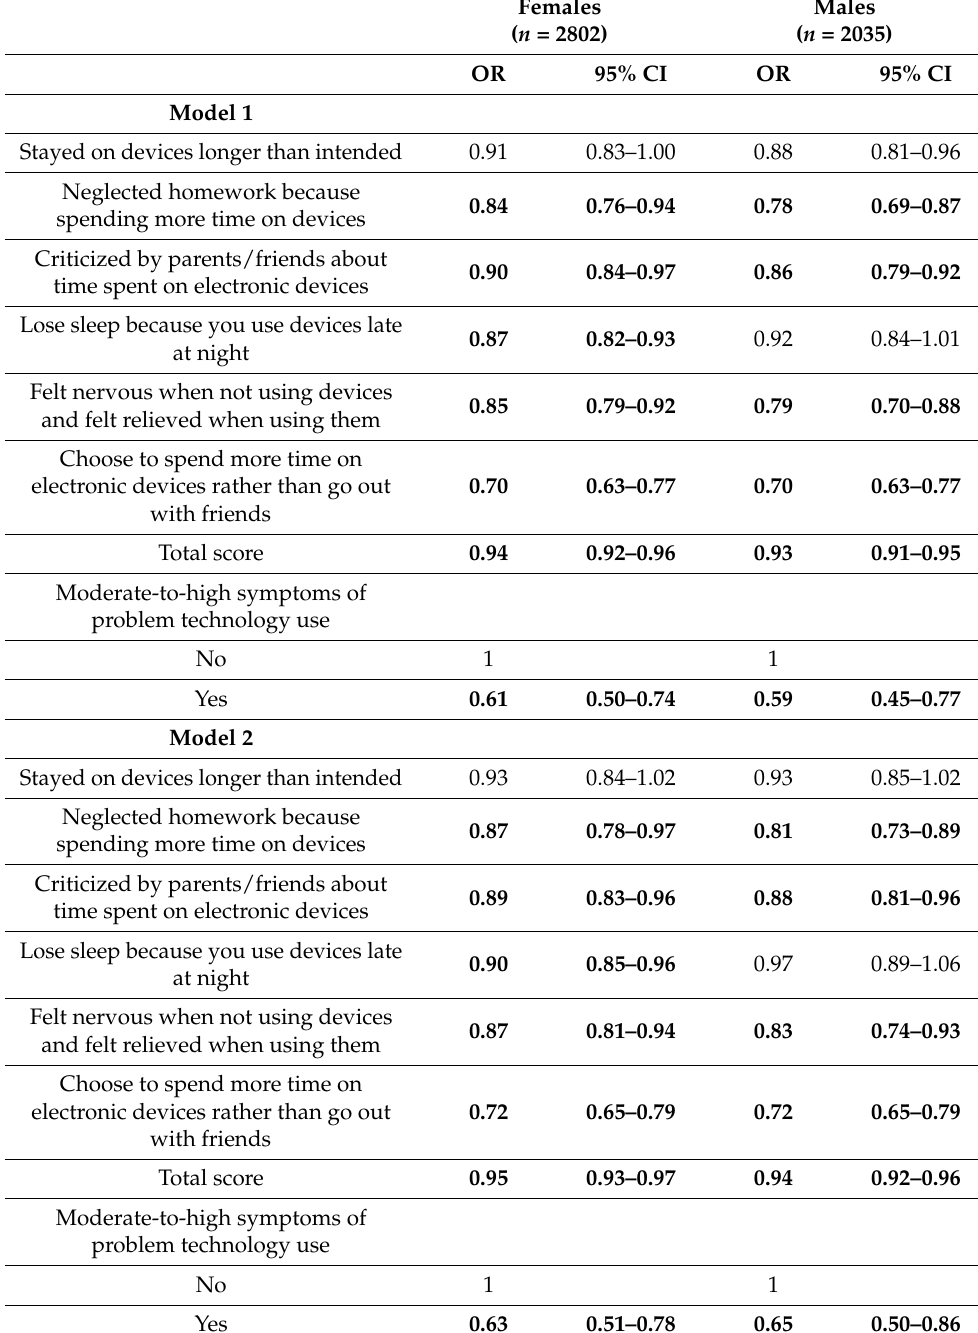
Table 4. Associations of moderate-to-high symptoms of problem technology use with school connect- edness among adolescent females and